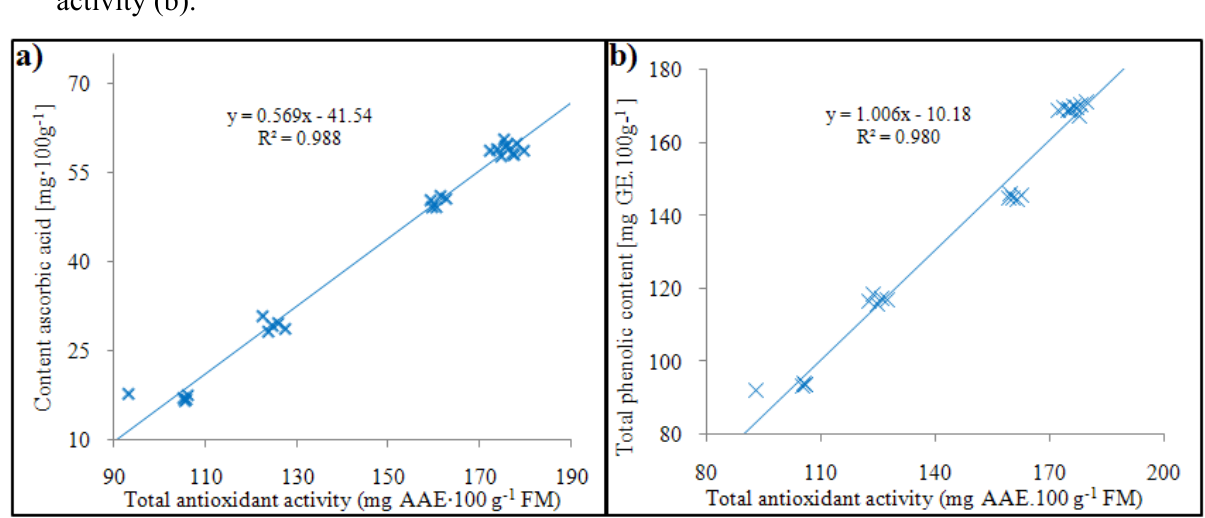
Figure 1. The correlation between the ascorbic acid content and total antioxidant activity (a); the correlation between the total content of phenolic compounds and total antioxidant activity (b).